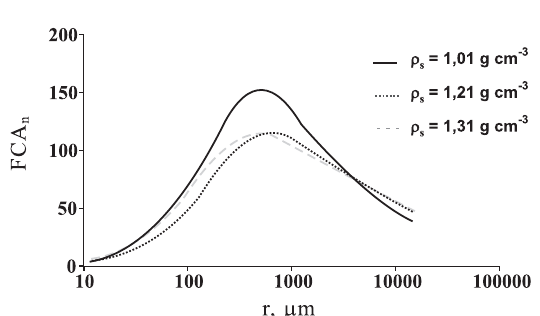
Figura 3. FCA das amostras com granulometria n dadas por D . Figura 5. FCA n para os agregados de f